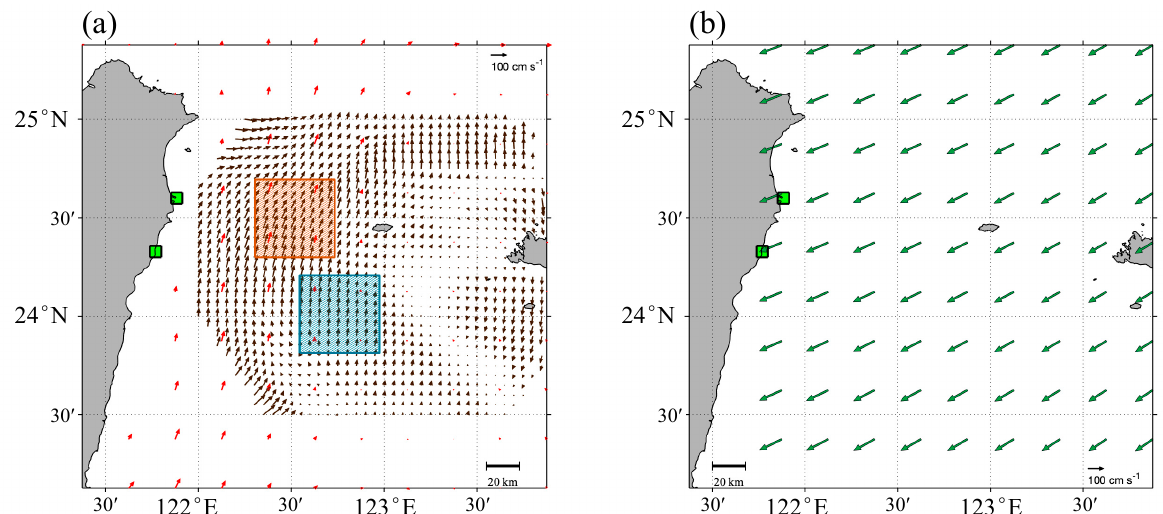
Figure 7. Mean SGV, HFR, and wind vectors from 1 January 2013 to 31 December 2013. ( a ) The red arrows are the SGV flowing from south to north; the black vectors are HFR measurements of the sea-surface current. The two grid regions where complex correlations are computed for box-averaged currents are also shown with the orange cell designated ROI 1 and the blue cell designated ROI 2. ( b ) Mean wind velocities, which are from the northeast.